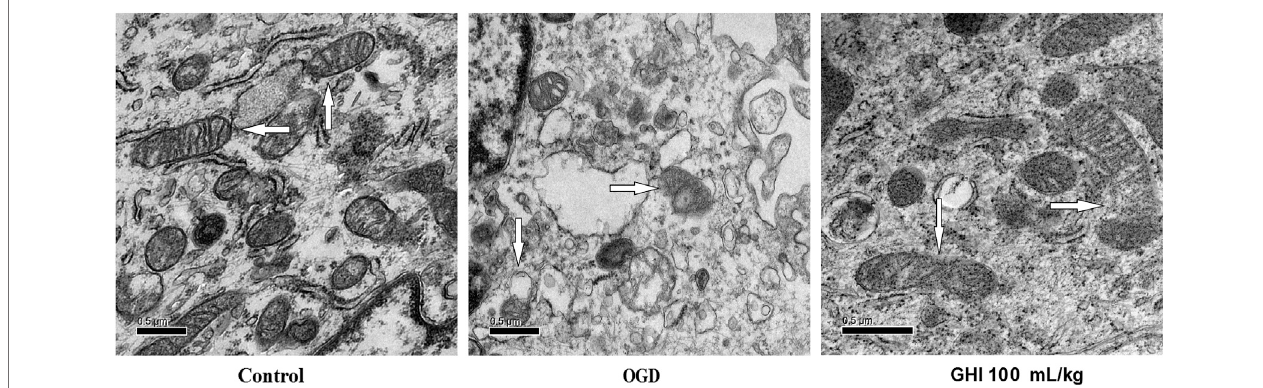
FIGURE 12 | Evaluation of the mitochondrial ultrastructure by electron microscopy (n (cid:2) 3).